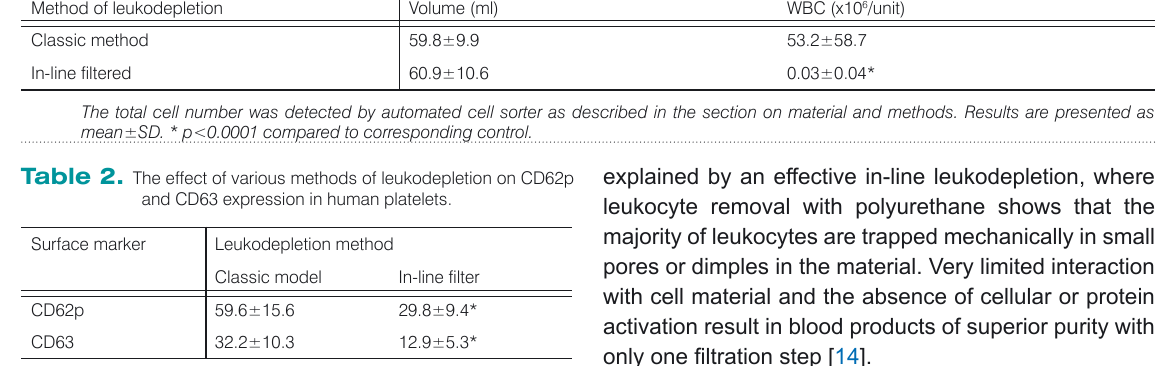
Expression of CD62p and CD63 in platelets was evaluated by flow cytometry, as described in the section on material and methods. Results are expresed as mean±SD of positive cells. * p<0.05 compared to the corresonding